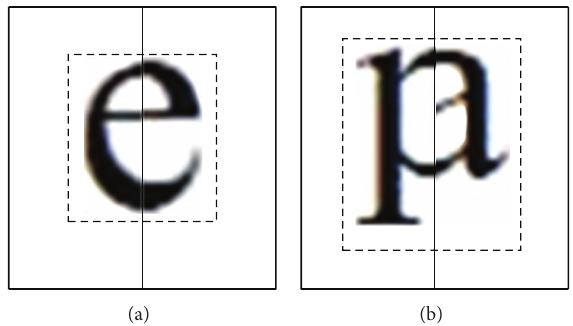
Figure 11: The character on the joint boundary is identifiable (a). The character on the joint boundary is unidentifiable